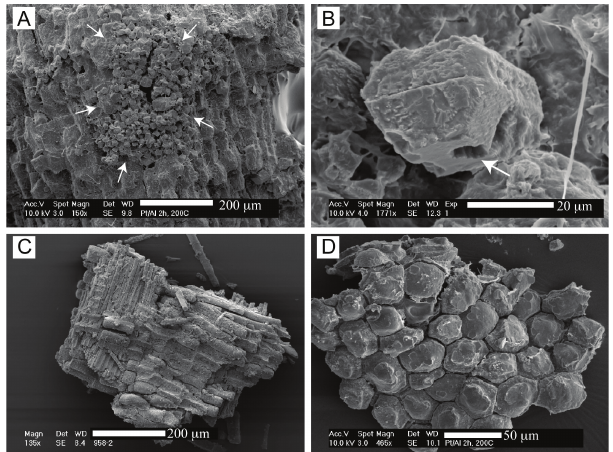
Fig. 4. (a–b) Scanning electron microscope (SEM) micrographs of a mineralized root. (a) Concentration of whewellite crystals (white arrows) due to wood tissue consumption by wood feeders (Kani site, Ivory Coast). (b) Released calcium oxalate crystal found in a decayed root, showing dissolution features (white arrow; Biga site, Ivory Coast). (c–d) : SEM micrographs of calcite pseudomorpho- sis on wood tissues (Biga site). Calcite pseudomorphosis perfectly preserves cell and fibre details. (c) Former wood fabric, now min- eralized, showing various components: thin elongated features are former cellulose fibres; the other crystals are former parenchyma cells. (d) Calcite-mineralized parenchyma cells extracted from sap bleeding from a wound on a young iroko